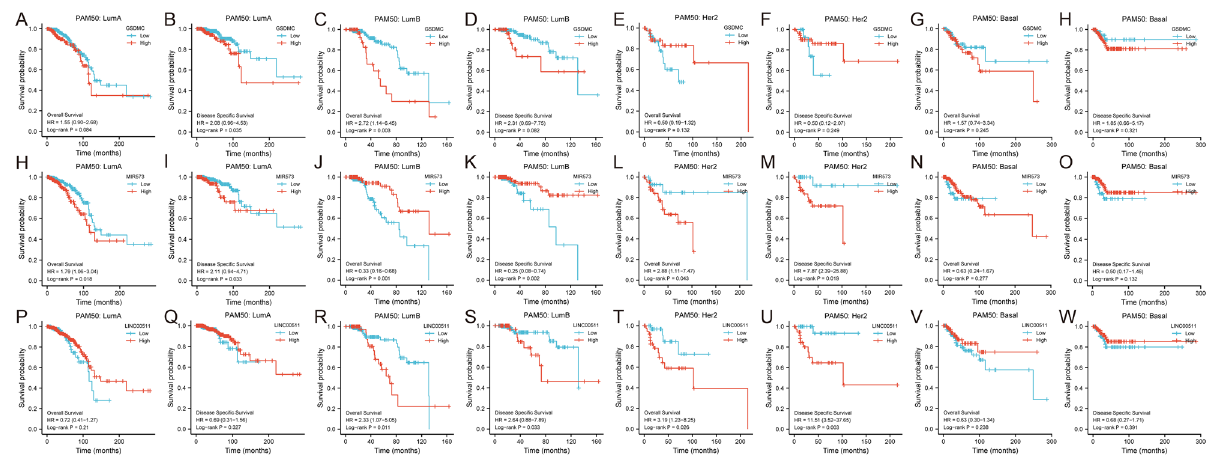
Figure 12. Association of GSDMC, hsa-miR-573 and LINC00511 expression levels and prognosis in patients with molecular subtyping of BRCA ( A–W ). LumA luminal A, LumB luminal B, N normal-like, Her2 Her-2 enrichment, Basal basal-like breast